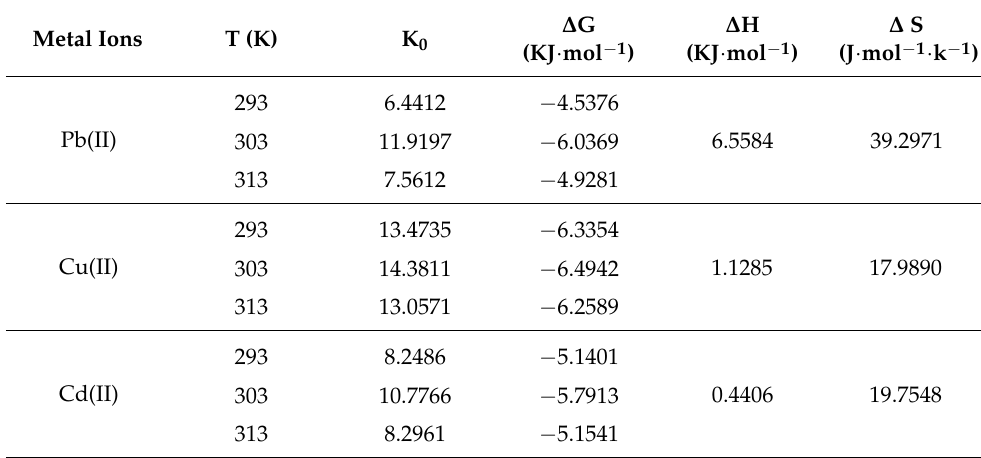
Table 4. Thermodynamic parameters for the adsorption of metal ions on the XMPC. Metal